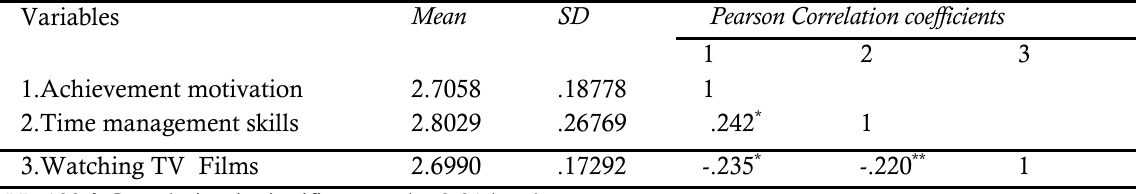
Table 3. The Correlation Watching TV films, Time management skills and